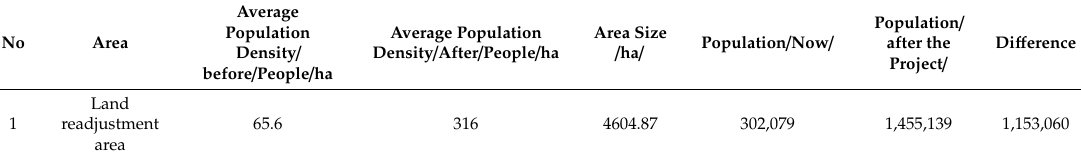
Table 8. Estimation of the increase in the urban carrying capacity.